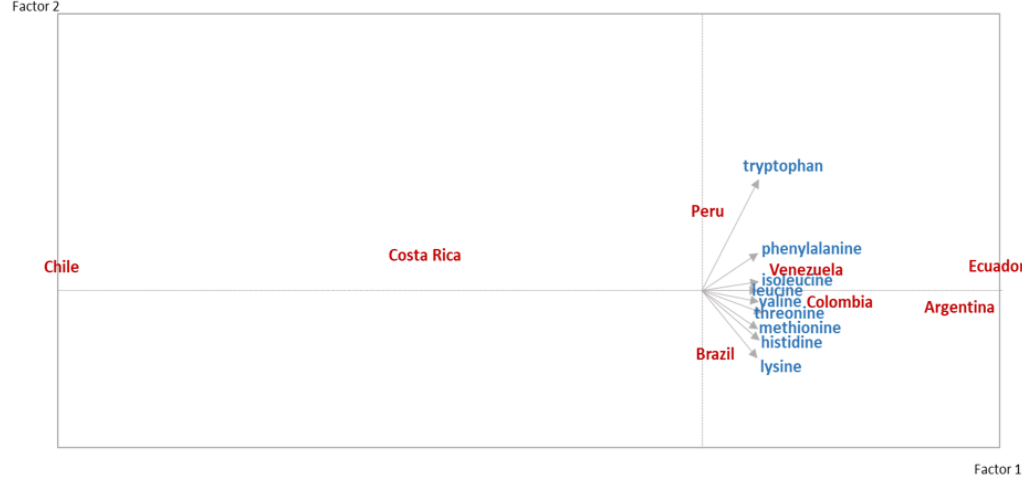
Figure 7. PCA Factorial Biplot: essential amino acid